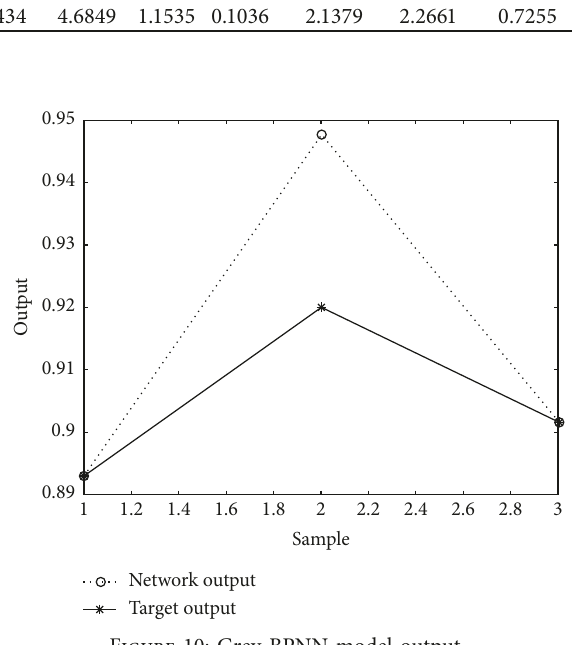
Figure 10: Grey-BPNN model output.